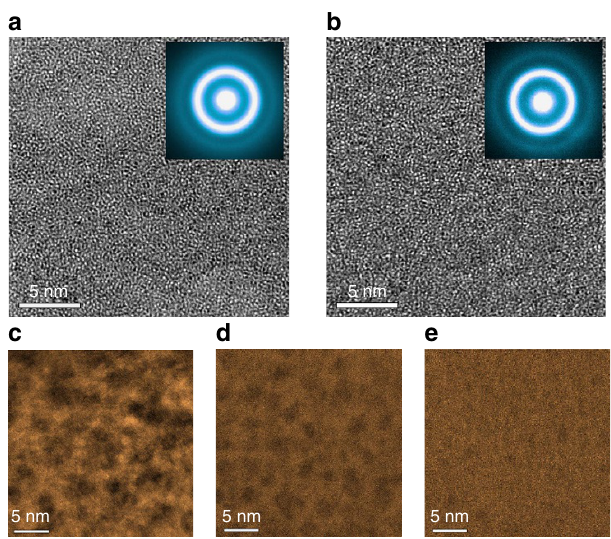
Figure 2 | Microstructure of the hyper-quenched and sub- T g relaxed metallic glass. HRTEM images of ( a ) the hyper-quenched metallic glass and ( b ) the metallic glass relaxed at 553K for 720min. High-angle annular dark-field scanning TEM (HAADF-STEM) images of ( c ) the hyper- quenched metallic glass, ( d ) the metallic glass relaxed at 553K for 5min and ( e ) relaxed at 553K for 720min. All the samples were prepared using gentle ion milling.